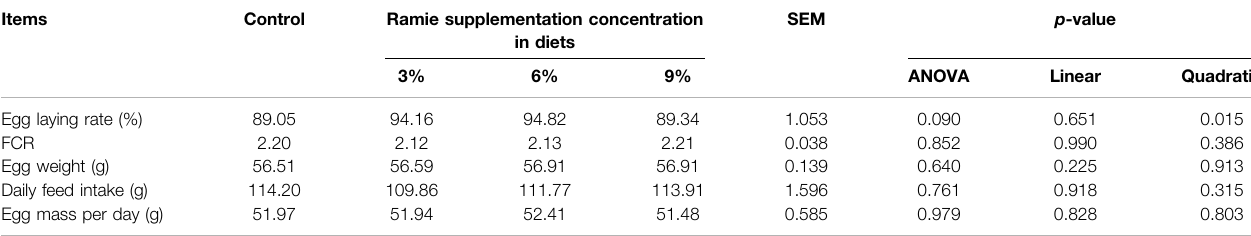
TABLE 2 | Effects of dietary ramie supplementation on laying hen production performance. Items